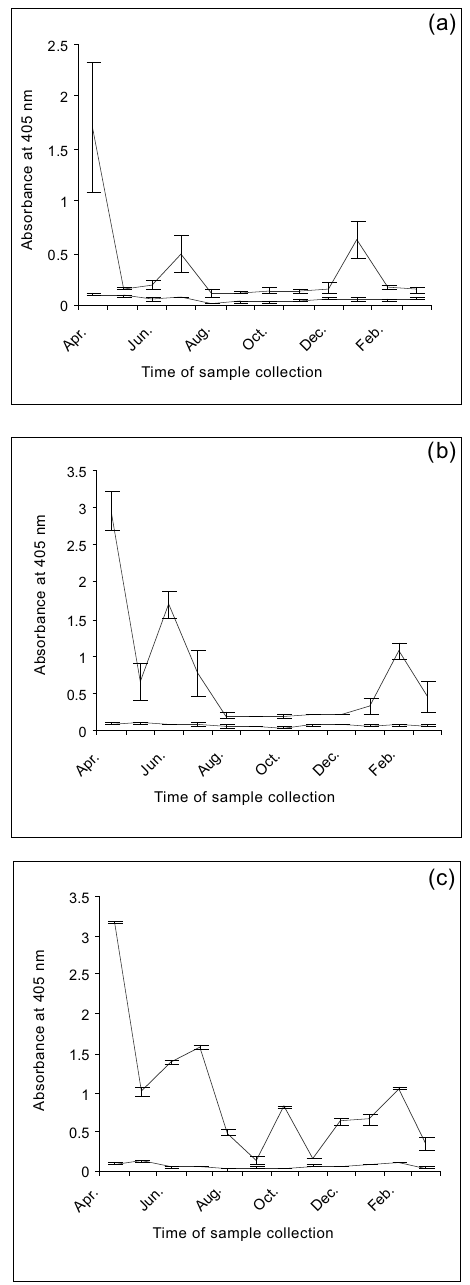
Fig. 2. Average monthly absorbance (A ard error values of sap extracted from tissues of almond cultivars: (a) Doma, Frinces, and Tuono; (b) S.F.121 and Texas; and (c) Ne Plus Ultra, infected with Prunus necrotic ringspot virus in 2001–2002, in the Tafila area. Baselines are the average monthly A